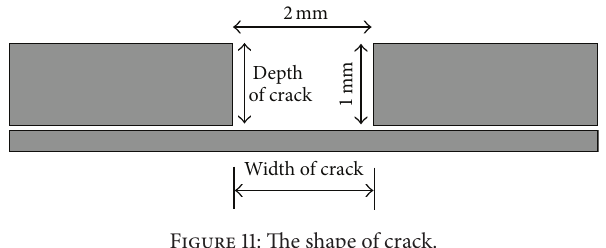
Figure 11: The shape of